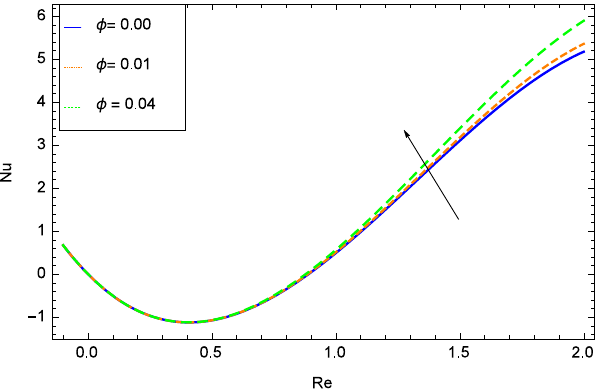
Figure 23. Nusselt number ( Nu ) when h = − 0.40, β 1 = 0.10, M = 0.10, Pr = 6.80 and various values of φ against Reynolds number Re for (CuO-H 2